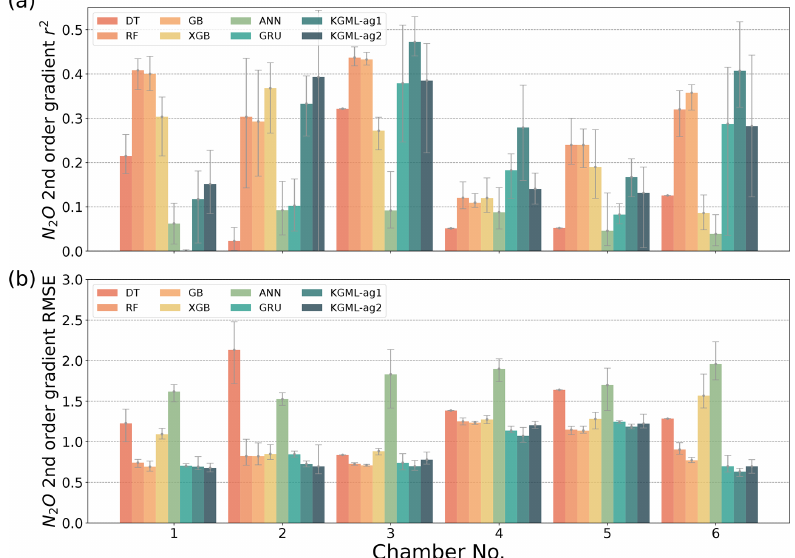
Figure 5. The comparisons of N 2 O flux prediction accuracy r 2 (a) and (b) RMSE from leave-one-out cross validation, between four tree- based ML models (DT, RF, GB and XGB), two deep-learning models (ANN and GRU) and KGML-ag models in six chambers. Validation results for each chamber were based on out-of-sample predictions by models trained by other five chambers. The gray error bars are coming from the maximum and minimum scores of ensemble